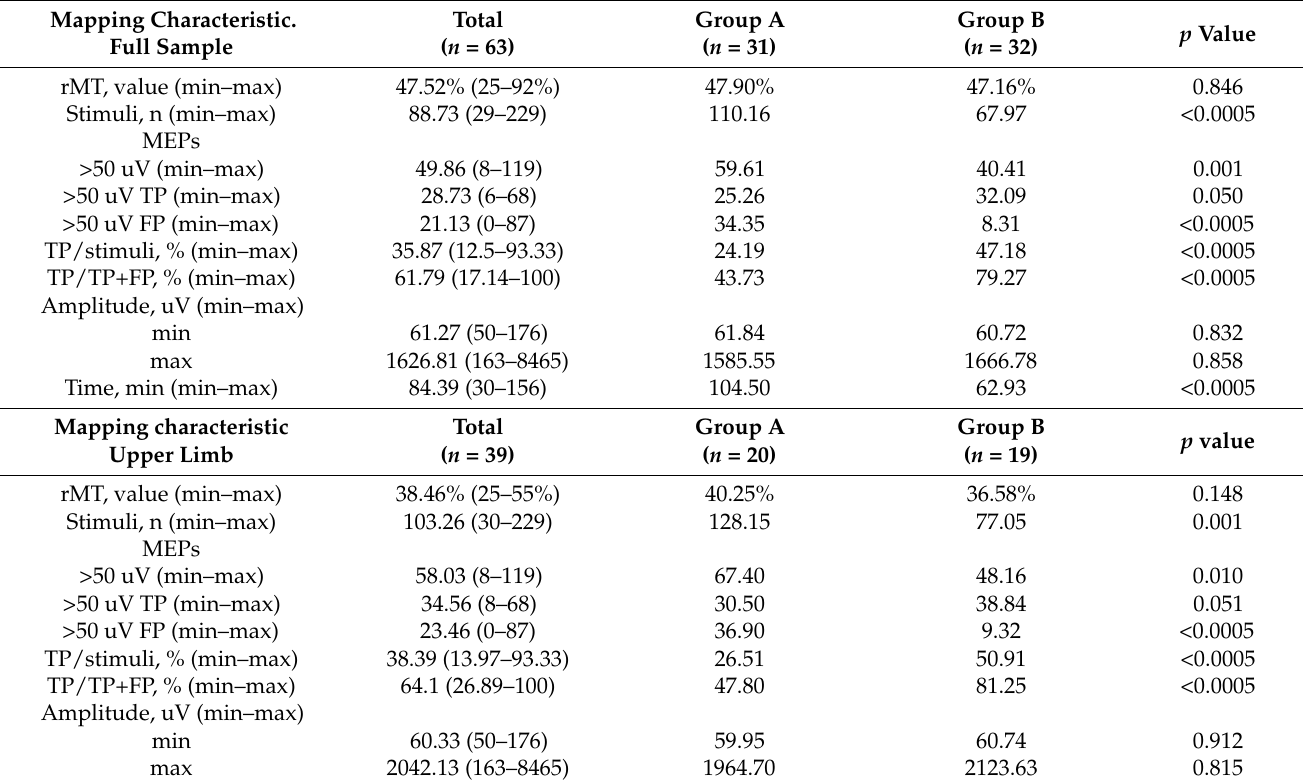
Table 3. Results of mapping parameters in the two groups and statistical analysis; the upper part shows the results of the maps of the full sample, while the lower part shows those of the subgroups. The statistical significance was set at p <